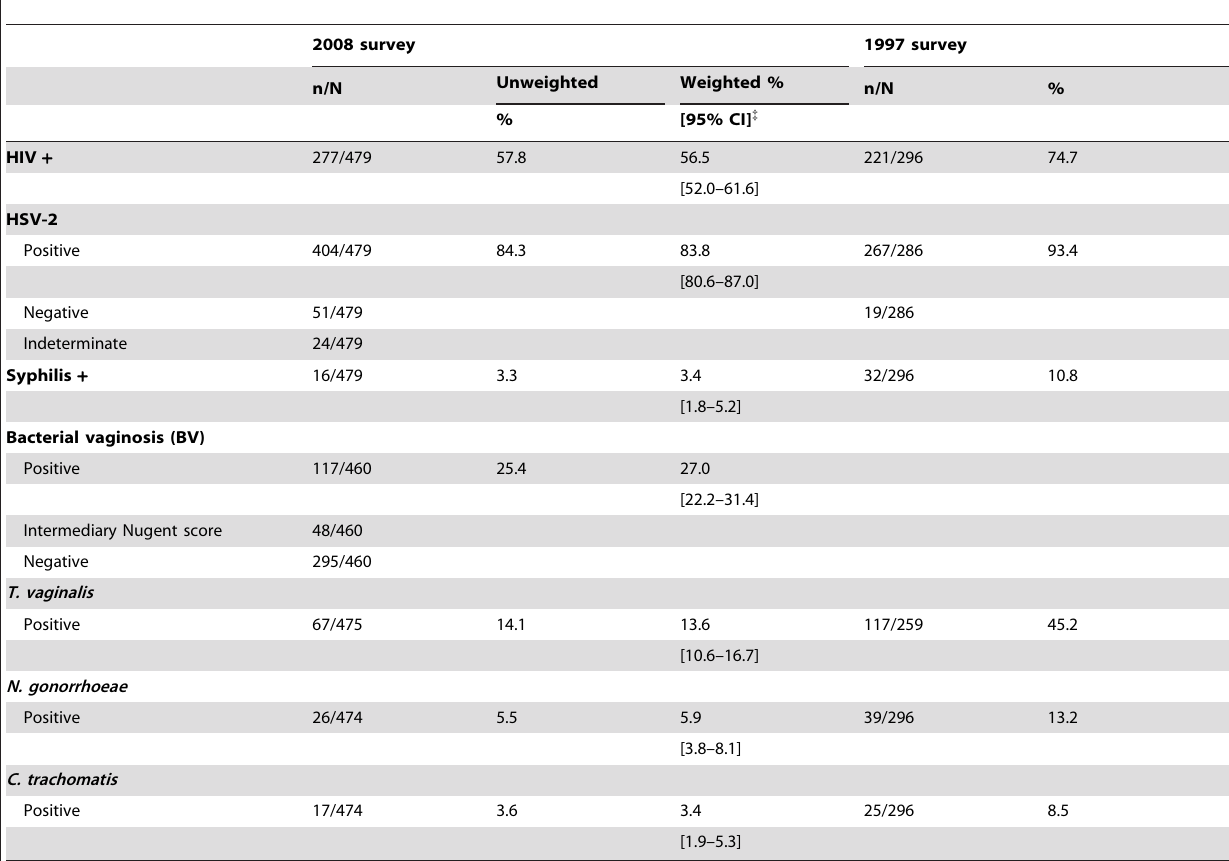
Table 2. Prevalence estimates of HIV and other STI among FSW in 2008 and in